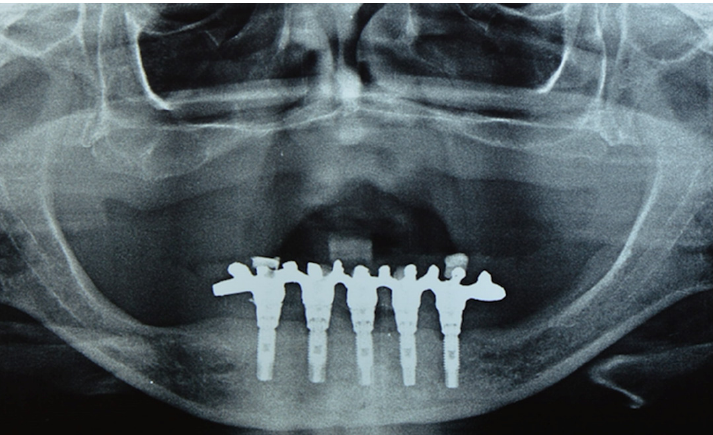
Figure 2. Radiographic aspect of Brånemark protocol mandibular prostheses (experimental group), showing external hexagon implants supporting a fixed mandibular prosthesis.